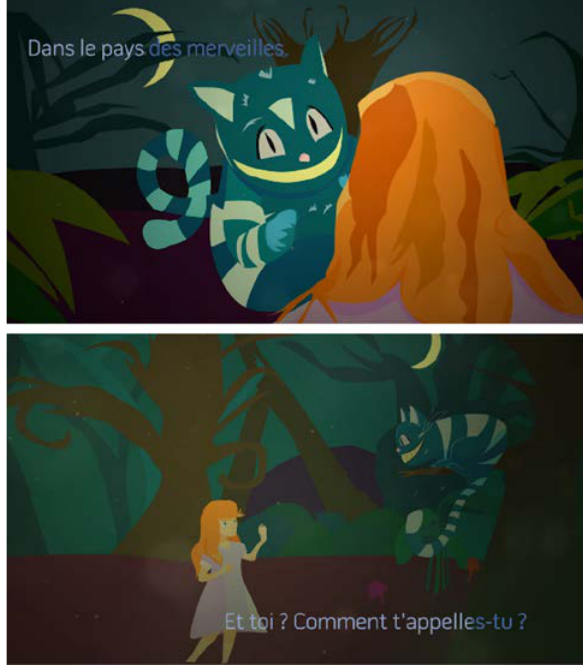
Figure 2 | Sample captures of the animated narrative story. The dynamically highlighted subtitles assist the learner in comprehending the speech plot and be emotionally linked to virtual characters.